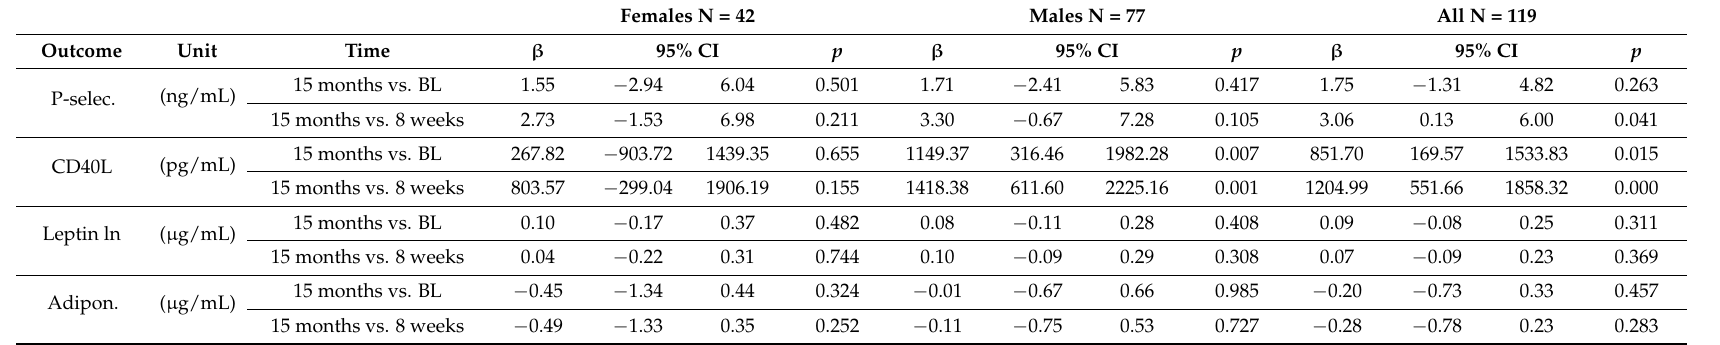
Table 5. P-selectin, CD40L, leptin, and